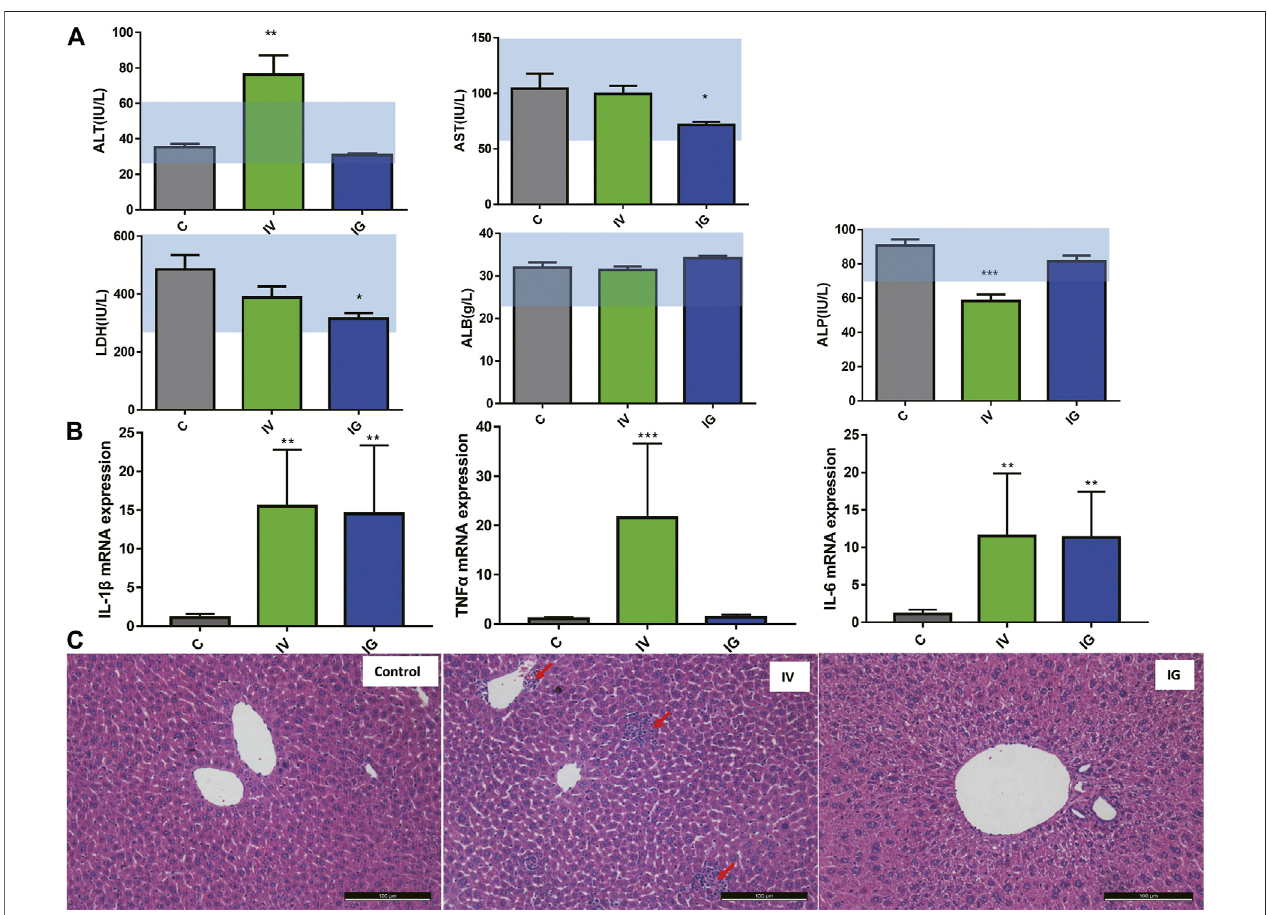
FIGURE1 |(A) Effect ofdifferent exposure methods (IV and IG) on serum biochemistry, including ALT, AST, ALP, LDH and ALB. Light blue bars indicate therange ofvaluesobtainedfromhealthyICRmice. (B) IL-1b,TNFaandIL-6mRNAexpressioninmouseliver. (C) Histologicalexaminationofliverfromthemouseofcontrolgroup, IV and IG group, red arrow: in fl ammation site. The data are expressed as the mean ± SD, p p < 0.05, pp p < 0.01, and ppp p < 0.001 compared with the control.